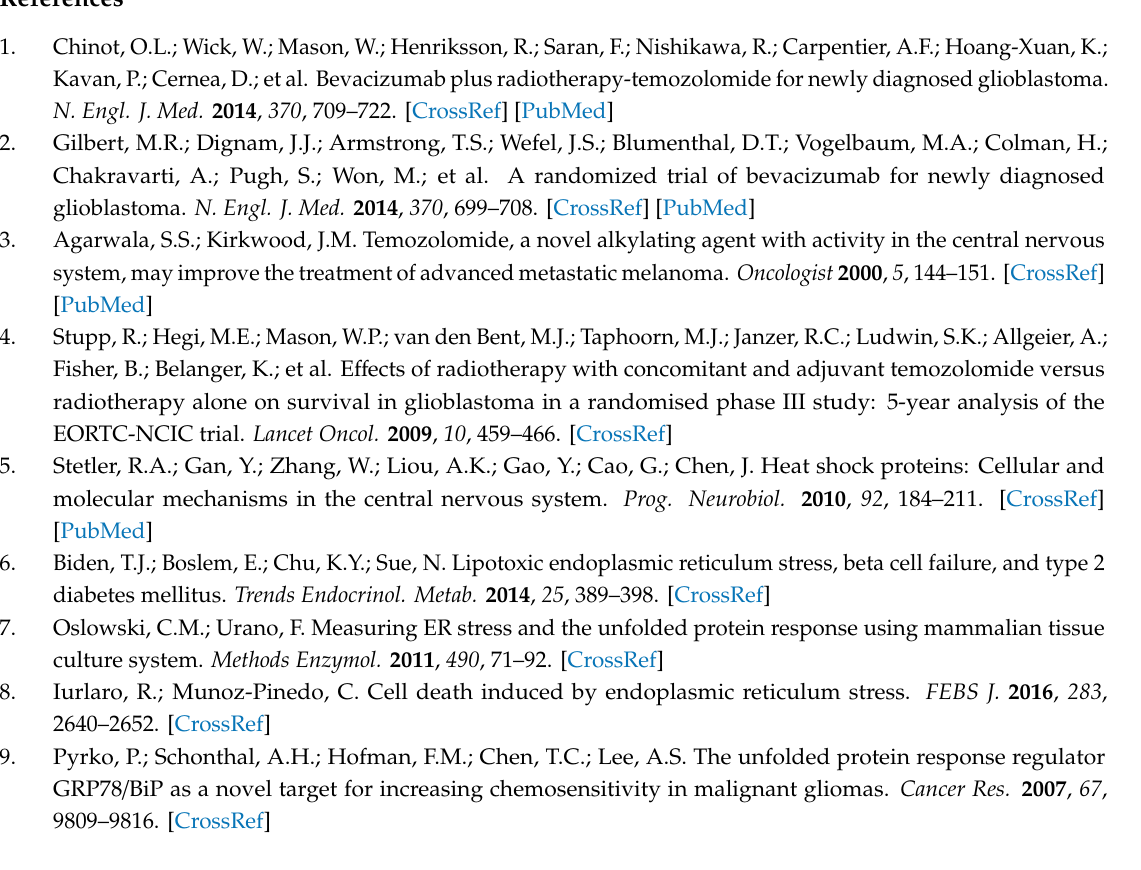
Figure S1: Roles of Sp1 in regulating UPR